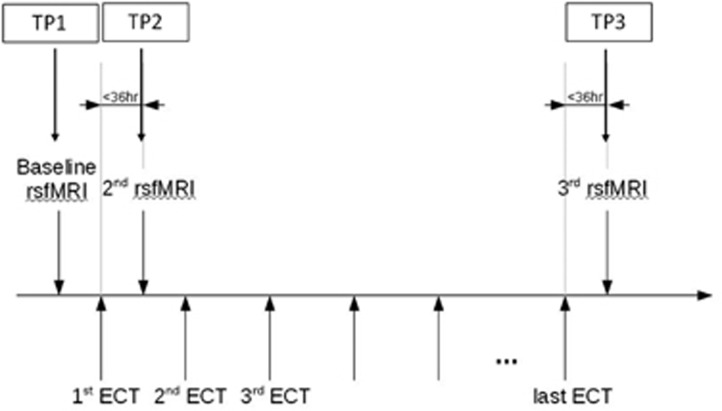
Study design. Patients underwent a course of bifrontal ECT (3 times per week) and were scanned 3 time points during treatment. They were scanned at baseline, within 36 h after the first ECT treatment and within 36 h after the last treatment. The last ECT treatment was obtained at remission or achieved after the 8th ECT treatment if the patient had not remitted (ECT course might have continued for clinical reasons). ECT, electroconvulsive therapy; TP, time point.